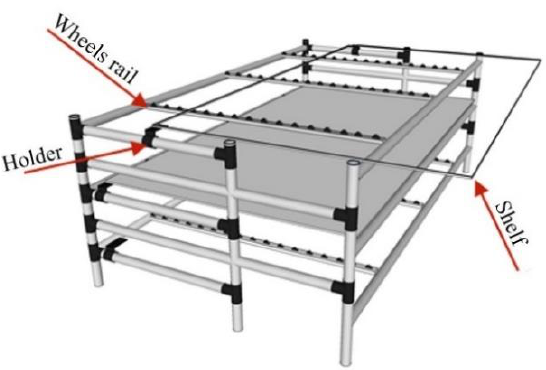
Figure 6. Detail of mobile shelf of the designed